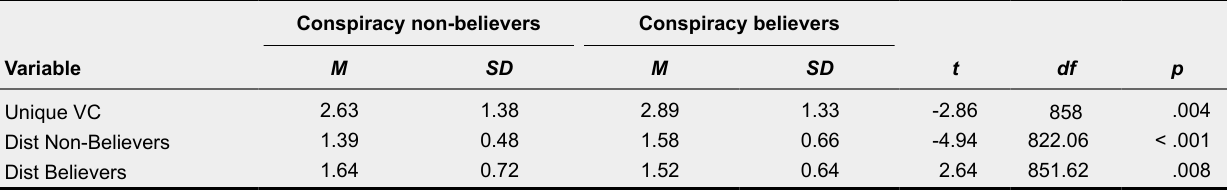
Mean Differences Between Individuals Endorsing and Not-Endorsing Belief in Smoleńsk Conspiracy